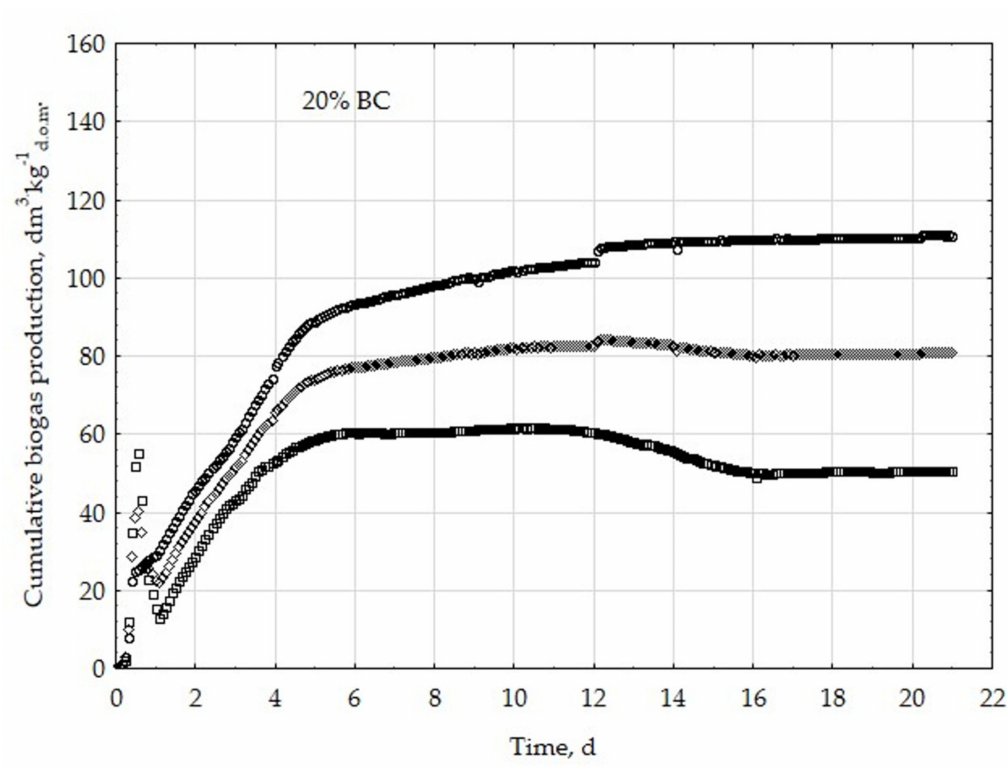
Figure A7. Biogas production from BSG: cumulative curves in variant with biochar addition at the level of 20%. The number of repetitions was three.